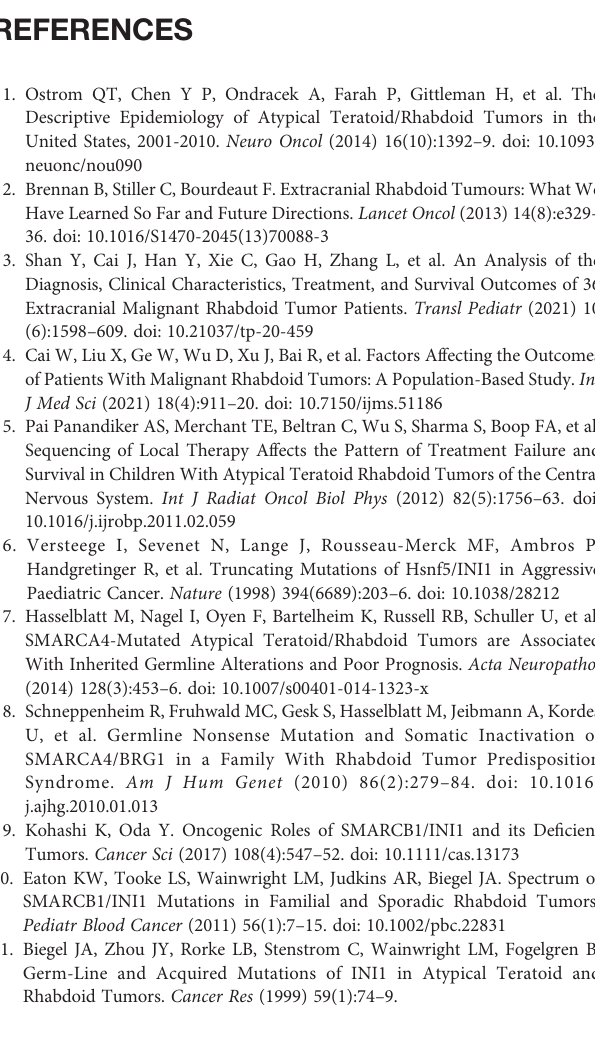
utilizing 36 genes (see “ Methods ” ) known to be differentially expressed in distinct AT/RT subgroups. The samples are colored by their RT subgroup as called by methylation pro fi ling and as central nervous system (CNS) or non-CNS indicative of the tumor location. Supplementary Table 1 | Exome sequencing metrics. Top: the 10 samples obtained from individuals are listed along with the type of tissue (tumor or comparator), sample type, mean depth of target exon coverage, and percent of targeted bases per gene sequenced to 20× coverage. Bottom: metrics from RNA- sequencing. The seven samples upon which RNA-seq was performed are listed along with tumor type, sample preservation type, total number of reads, number of reads mapped to GRCh38, and number of coding and untranslated region reads. The corresponding dbGap ID for each sample is listed. FFPE, formalin- fi xed paraf fi n-embedded; GRCh38, human genome assembly (hg38) from Genome Reference Consortium; UTR, untranslated region Supplementary Table 2 | Single-nucleotide variants and copy number variants detected in clonality analysis. Variants detected in clonal tracking are listed with corresponding variant allele frequencies predicted from exome sequencing data. The color of the clone corresponding to – 5 is also noted. CASE DESCRIPTIONS | Clinical history of all three patients, which includes diagnostic details, treatment regimens, and the current clinical status of each